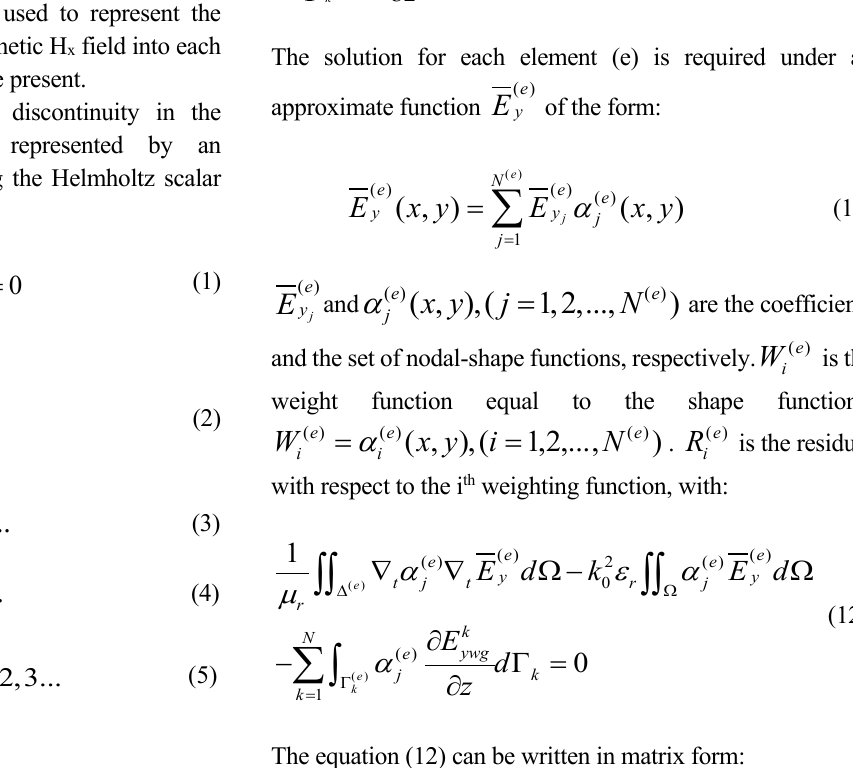
Figure. 1. Our analyzed based on the present procedure